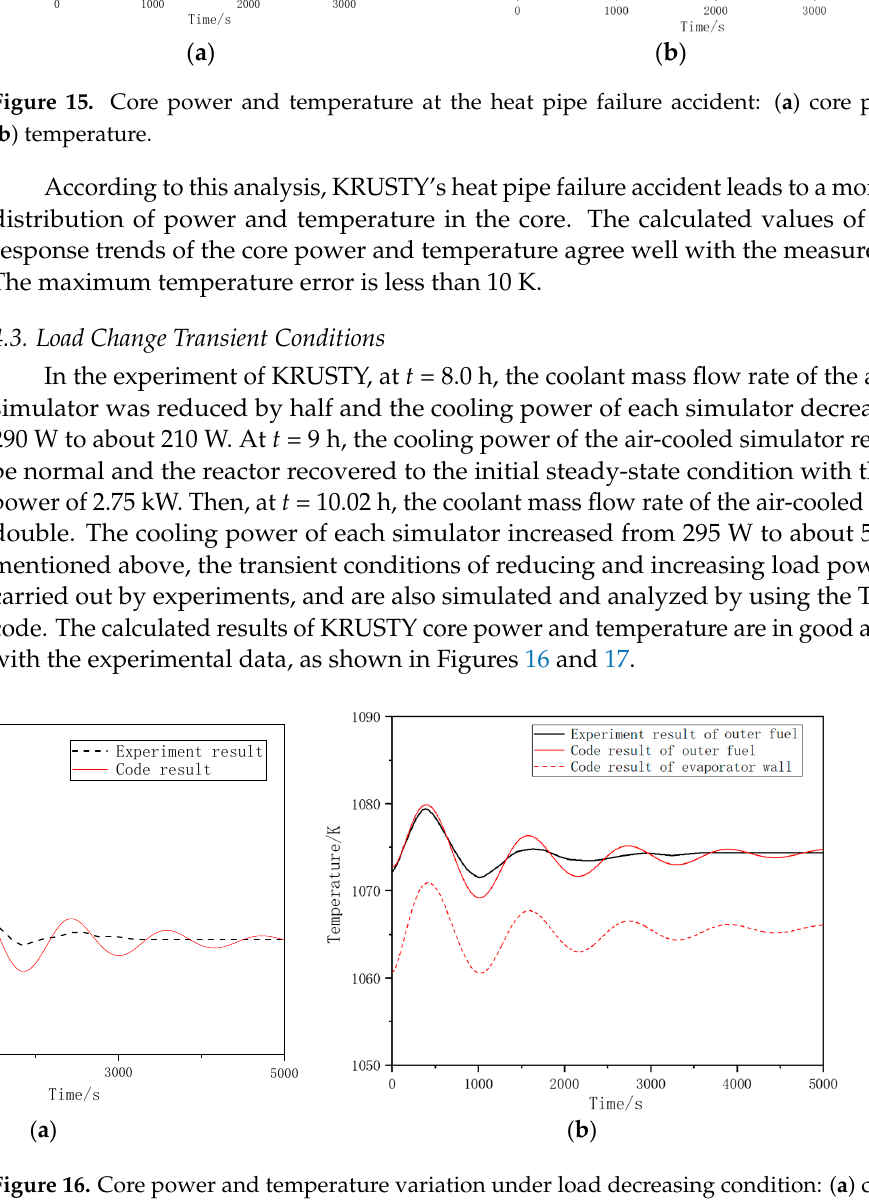
( b ) Figure 17. Core power and temperature variation under load increasing condition: ( a ) core power and ( b ) core temperature. 4.4. Loss of Heat Sink Accident For the KRUSTY experiment when t = 20 h, the Stirling converters were stalled (zero strokes) and the simulator flow was set to a very low rate, which was conducted to simu- late a complete loss of active heat removal of KRUSTY. In this experimental condition, the steady-state power of the reactor decreased from 2.6 to 1.5 kW and the average cooling power of the heat pipe condenser decreased from about 270 to 130 W. The loss of heat sink accident was analyzed by TAPIRSD and the transient response characteristics of KRUSTY are shown in Figure 18. After cutting off the flow rate of the simulator, the core temperature increased quickly, causing the reactivity and power to drop quickly. Finally, a new steady-state power that matched the cooling power was achieved. The calculated temperature at the outer surface of fuel increased by about 4 K within 2 h. This occurred because the radial temperature gradient of fuel was small at a lower power level. The temperature of the inner and outer fuel and the heat pipes would become close to the average temperature, which is consistent with the experimental results.